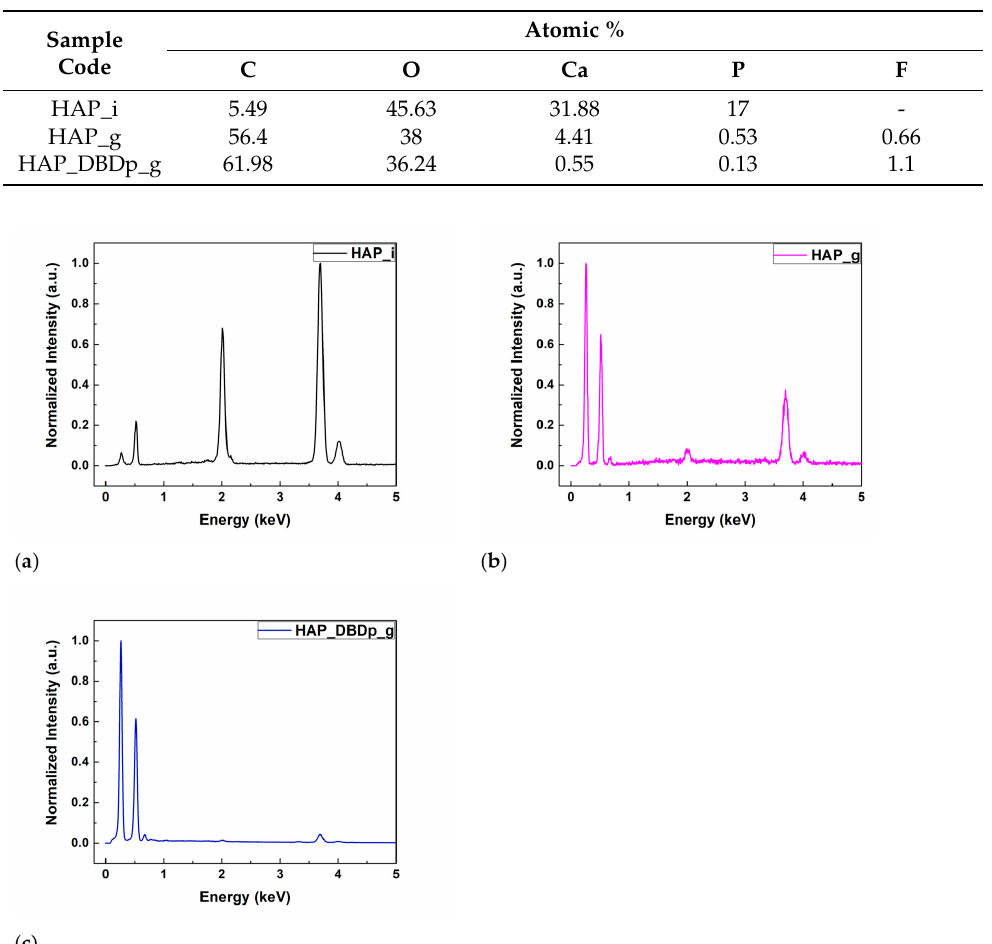
Table 1. Elemental composition (atomic %) of treated and untreated hydroxyapatite (HAP) surfaces measured by EDX.